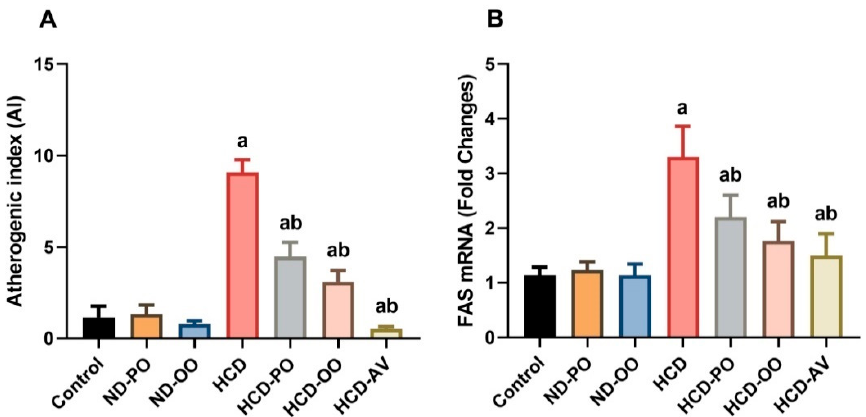
Figure 4. ( A ) Atherogenic index and ( B ) fatty acid synthase expression following treatment with palm oil (PO), olive oil (OO), or atorvastatin (AV) in high-cholesterol diet-induced hypercholesterolemia in rats.Data are expressed as the mean ± SD ( n = 7). Letters a and b indicate statistically significant differences between control rats and hypercholesterolemia rats, respectively, at p <0.05.